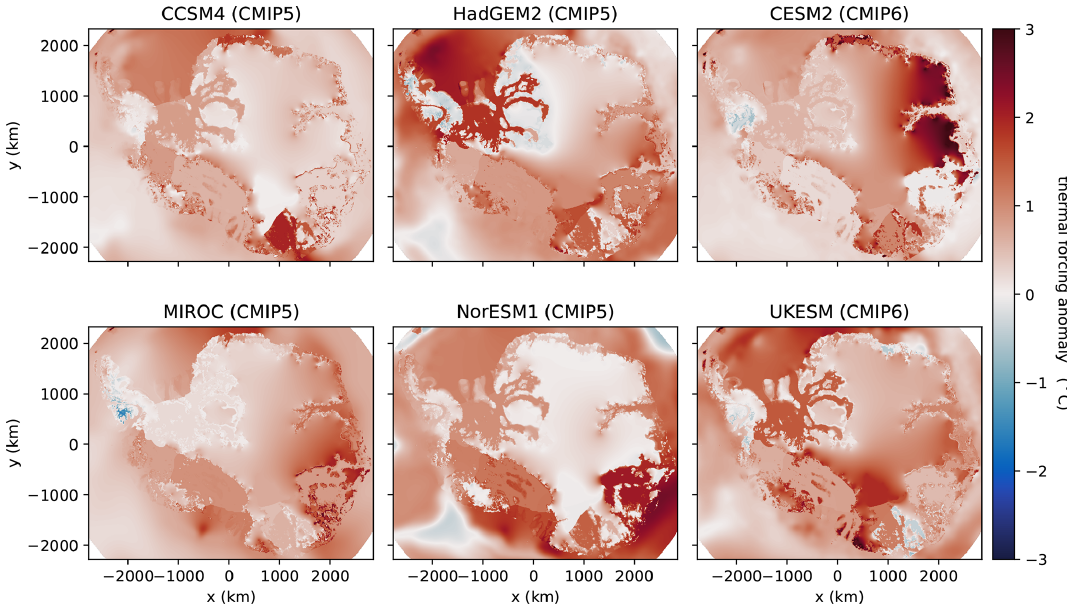
Figure 10. Ocean thermal forcing anomaly ( ◦ C) at z = − 510m for the four CMIP5 models and two CMIP6 models used in ocean-forced projection experiments. The anomaly is averaged over 2081–2100 and is computed with respect to the base period